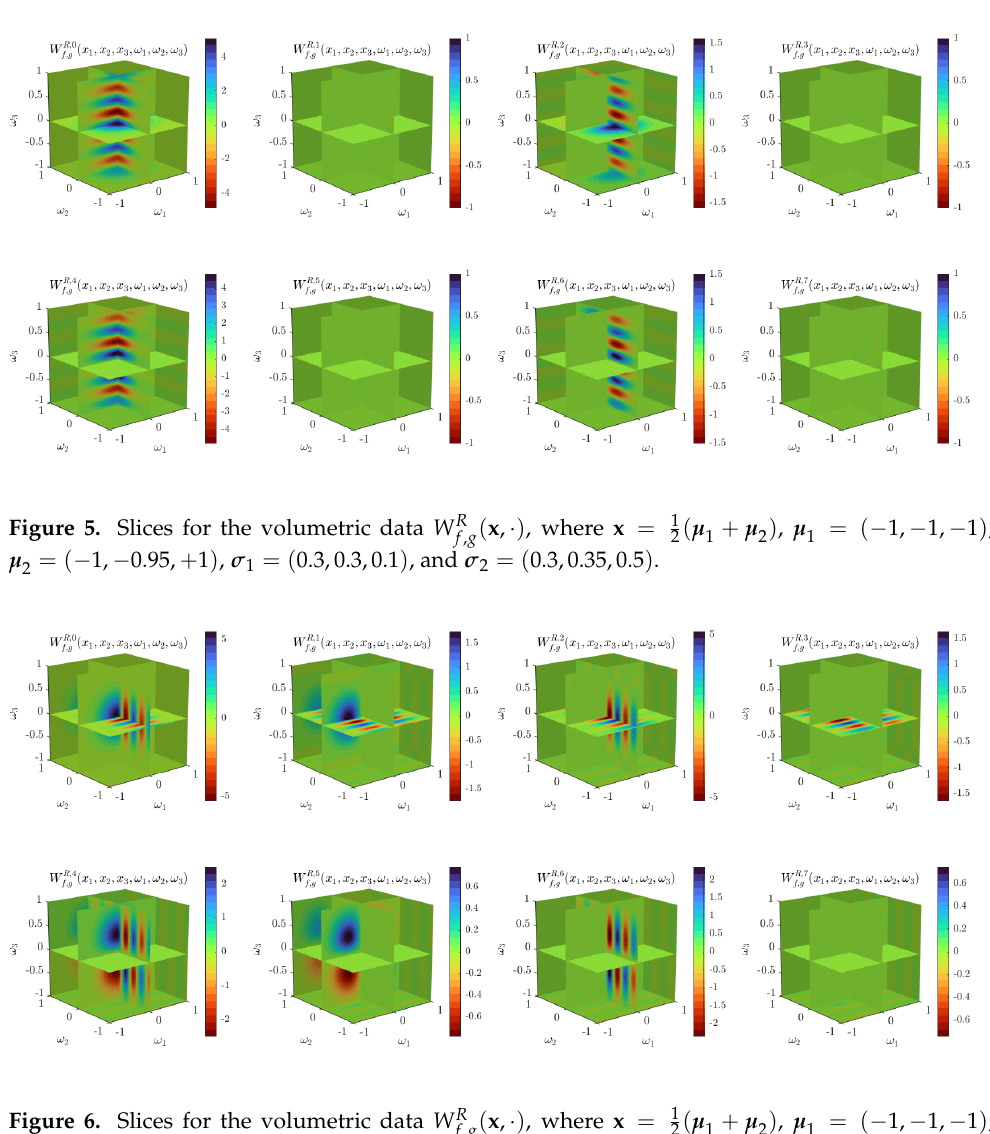
= ( 0.3,0.1,0.3 ) , and σ 1